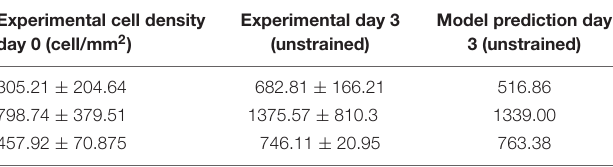
TABLE 2 | Parameters relating to cyclic strain.